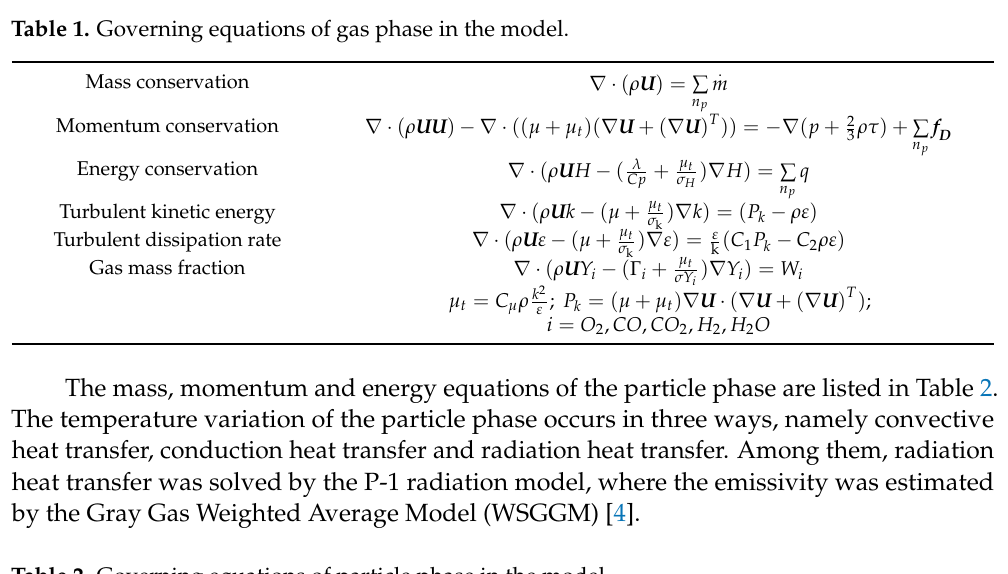
Table 2. Governing equations of particle phase in the model.